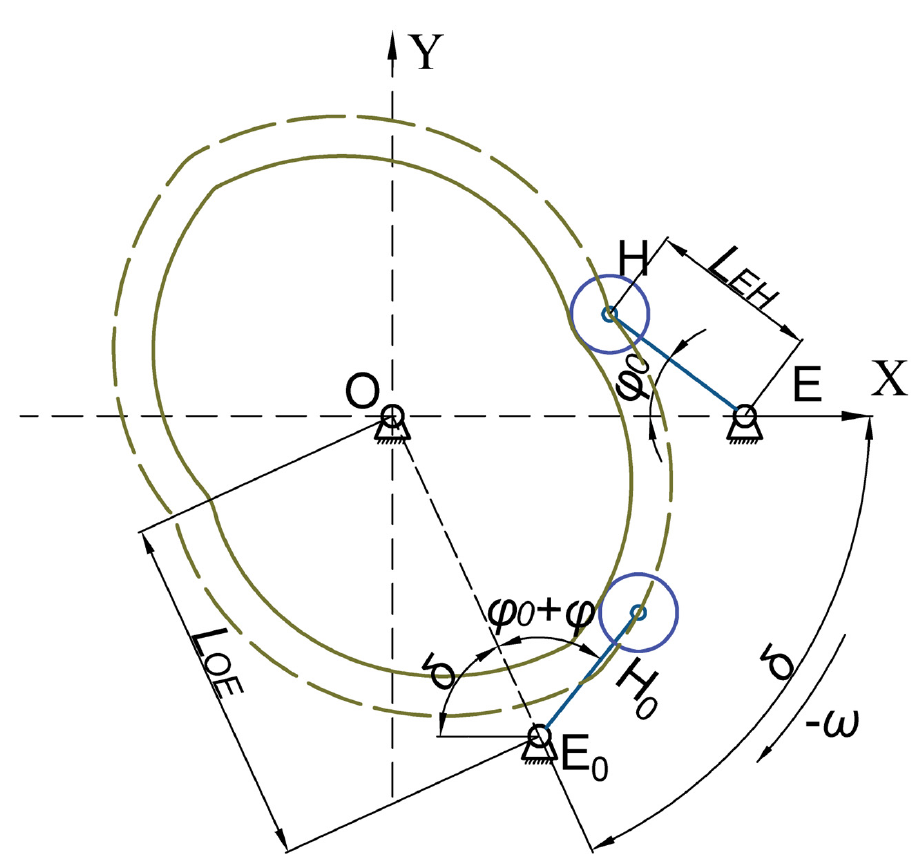
Figure 6. Pendulum–cam contour line design.